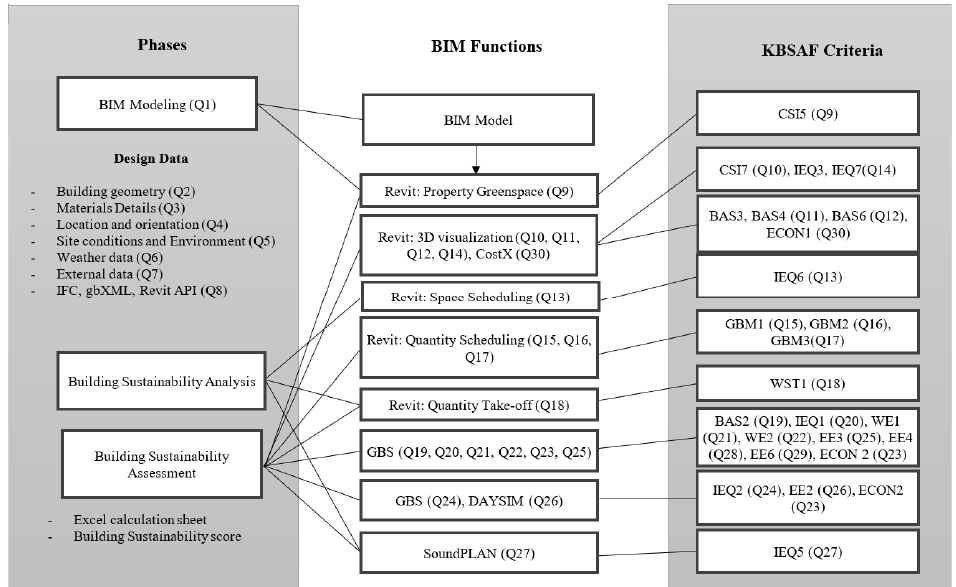
Figure 2. Conceptual Framework for BIM-based Building Sustainability Assessment in Kazakhstan (BIM-KBSAF).